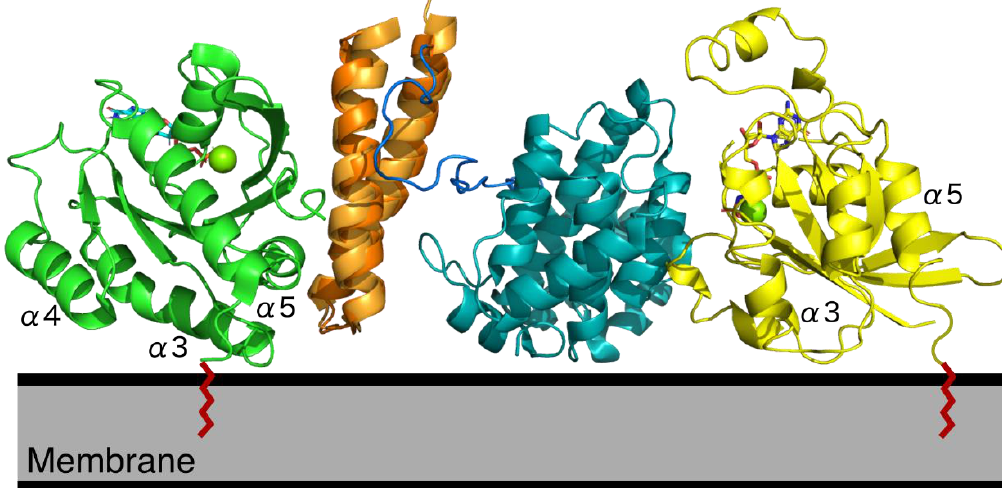
Figure 3. RLIP76 RhoGAP and RBD interactions. RLIP76 could interact simultaneously with both Ral and Rho family proteins. Cdc42 was docked to the RLIP76 didomain (2MBG) using the Cdc42-p50RhoGAP complex to overlay the RhoGAP domains (1AM4). The RBD of RLIP76 of this model was then superimposed with the RBD in the RalB complex (2KWI). The RLIP76 RBD is orange, the RhoGAP domain is cyan, the RLIP76 linker is blue, RalB is green and Cdc42 is yellow. Helices in RalB and Cdc42 that would contact the membrane in this orientation are labelled and their C-terminal lipid modifications are shown in red.